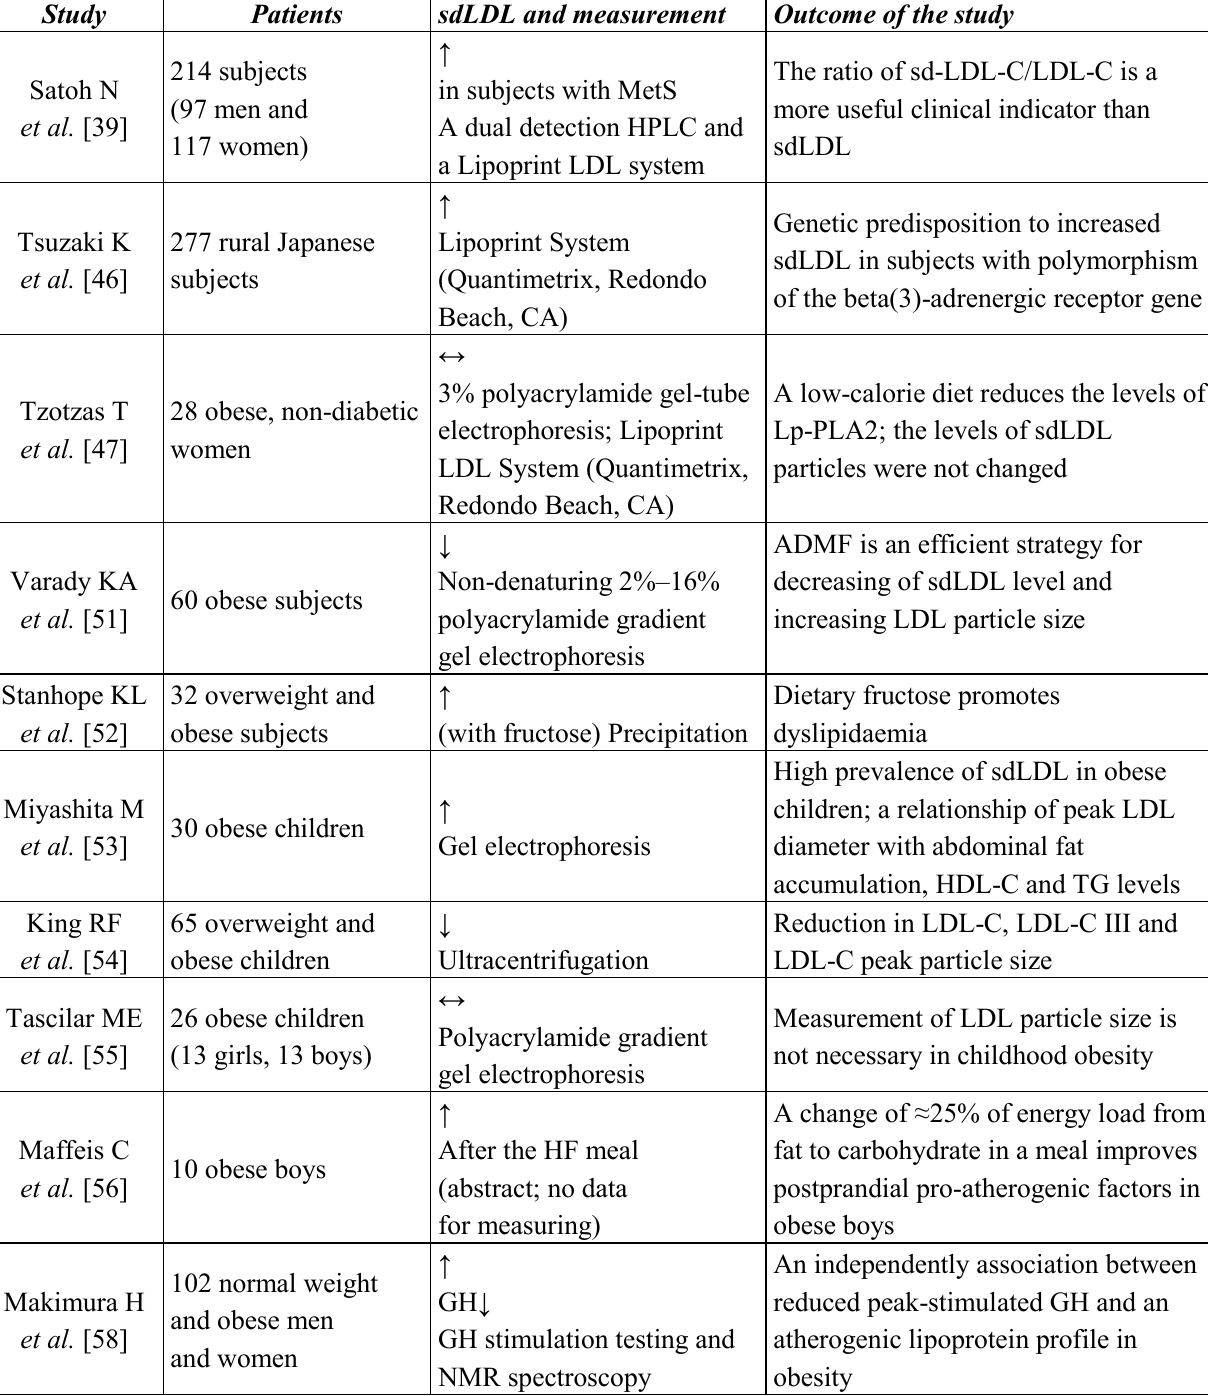
Table 2. Outcomes of the observed studies that have analysed small dense low density lipoprotein cholesterol (sdLDL) in overweight and obese